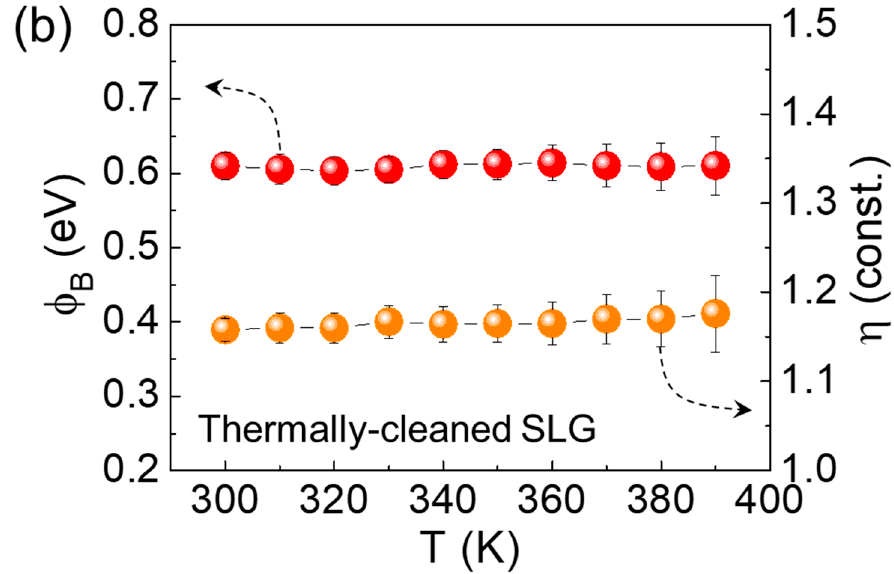
Figure 5. Magnitudes of ϕ B and η as a function of the temperature for the ( a ) ZnO/AT-SLG and the ( b ) ZnO/TC-SLG Schottky PDs. The error bars indicate the standard deviation from data obtained from multiple samples fabricated by identical procedures (i.e., five devices of ZnO/AT-SLG Schottky PDs and five devices of ZnO/TC-SLG Schottky PDs, see also Supplementary Materials).